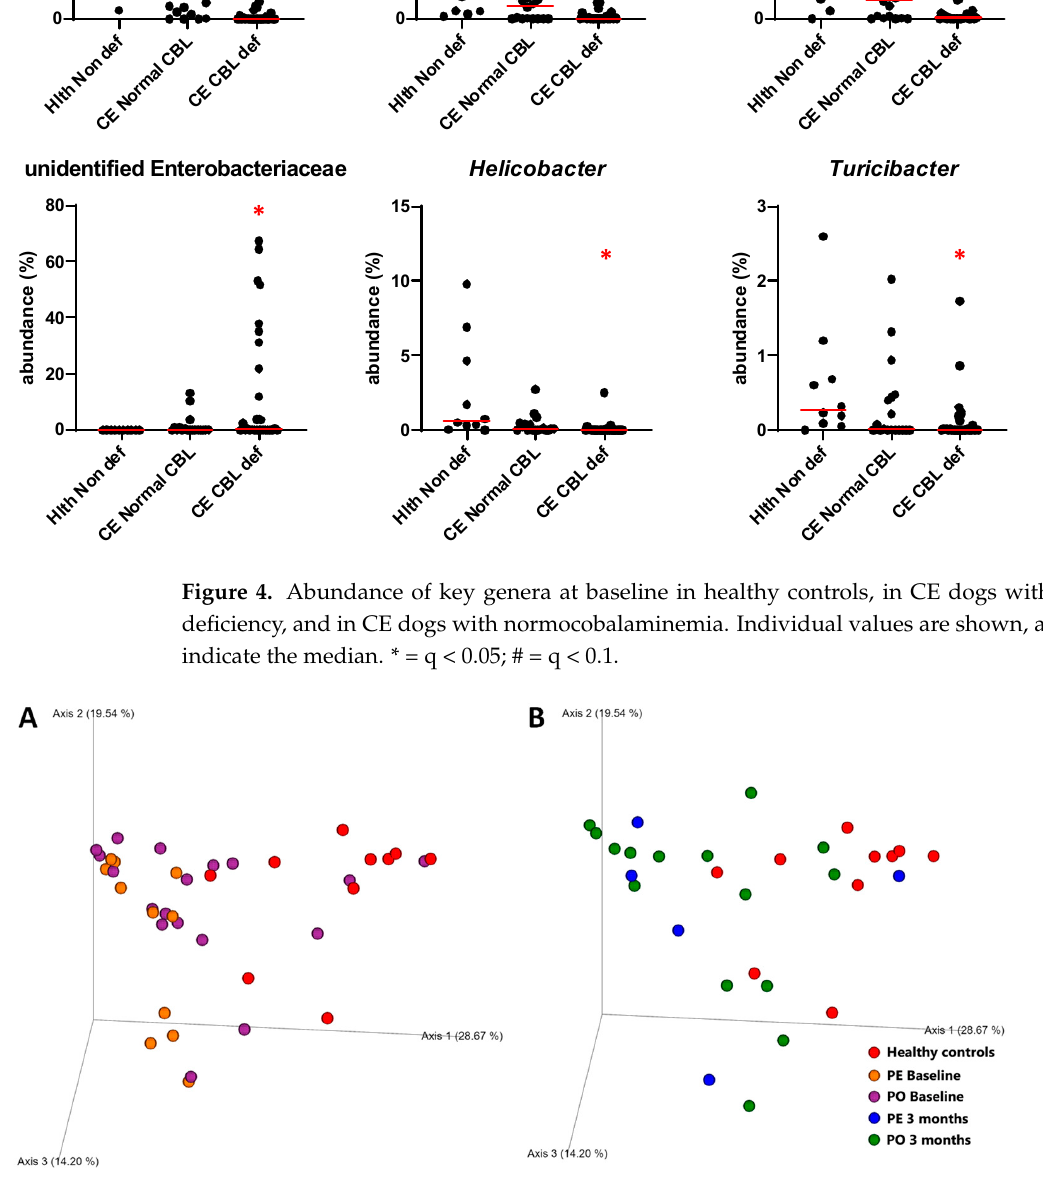
Figure 5. PCA plot of weighted UniFrac distances (beta diversity) of ( A ) baseline fecal samples from dogs receiving cobalamin supplementation parenterally (orange dots) or orally (purple dots), compared to healthy controls (red dots); and ( B ) 3-month follow-up fecal samples from dogs receiving cobalamin supplementation parenterally (blue dots) or orally (green dots), compared to healthy controls (red dots).